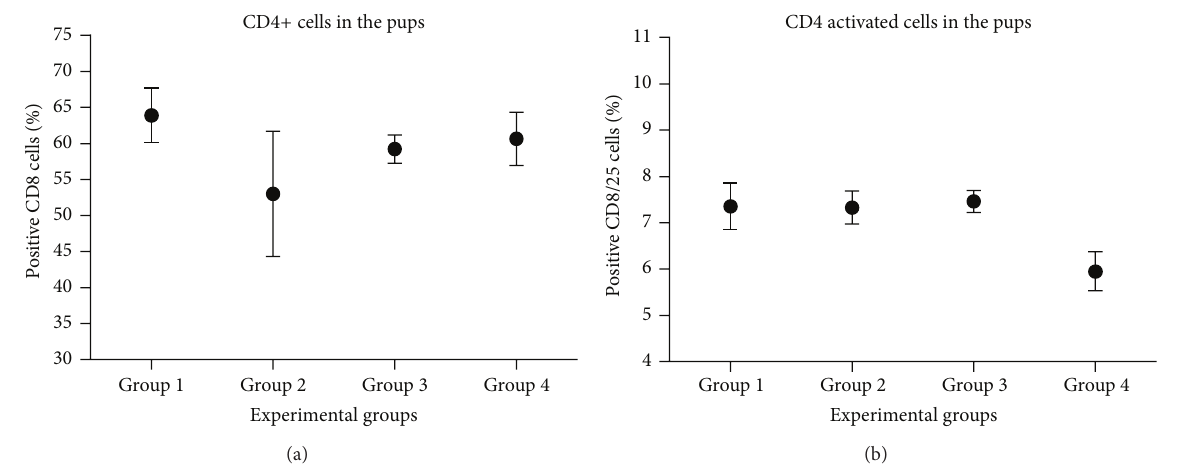
Figure 8: Evaluation of the total CD4 positive lymphocyte population (a) and the activated population (b). In the 𝑥 -axis, it showed the experimental groups and in the ordinates the average percentage of positive CD4 cells without activating or activated with his bar of